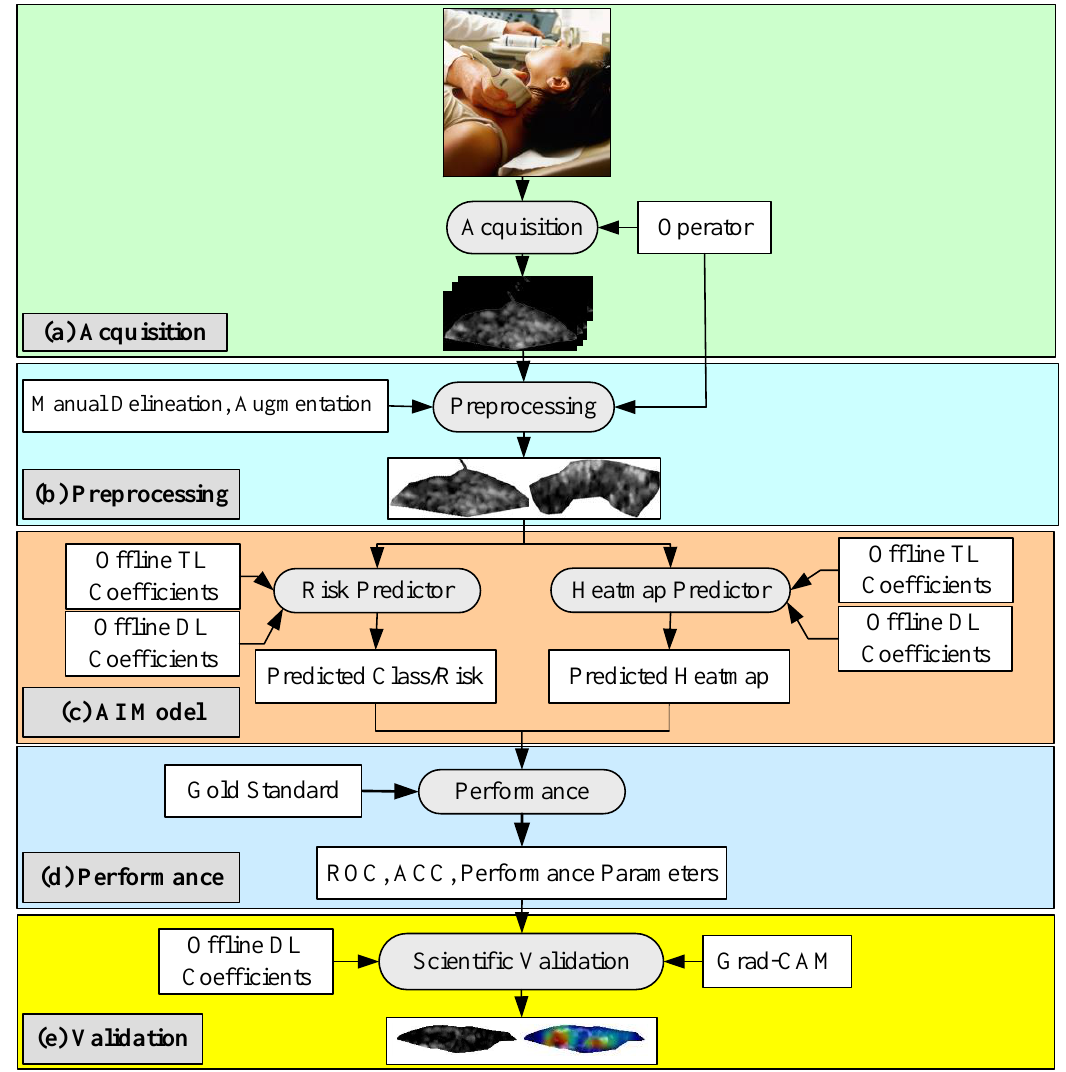
Figure 1. Online AI architecture of the Atheromatic™ 2.0 TL study (TL: transfer learning, DL: deep learning, and Grad-CAM: gradient-weighted class activation mapping).